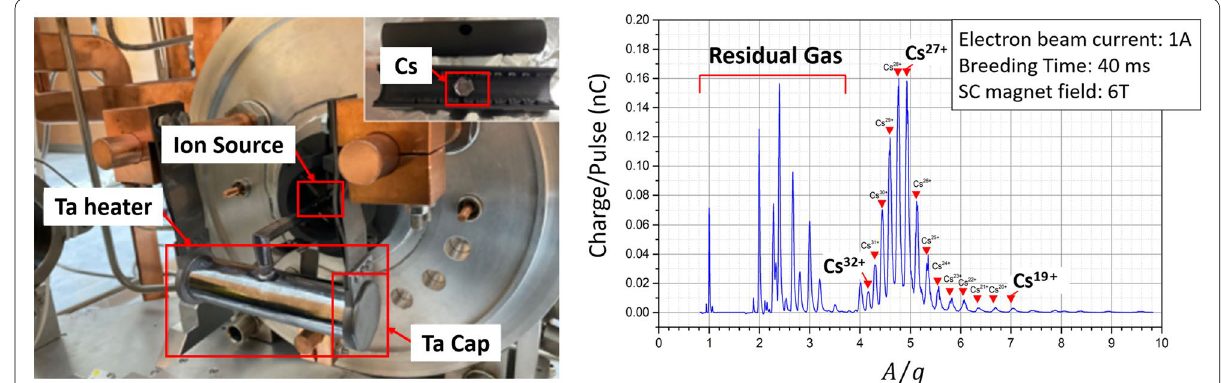
Fig. 8 Cs ion source placed in a hot-cavity Ta heater in TIS for commissioning the ISOL system and beamlines (left) and the measured A / q spectrum for the Cs beams